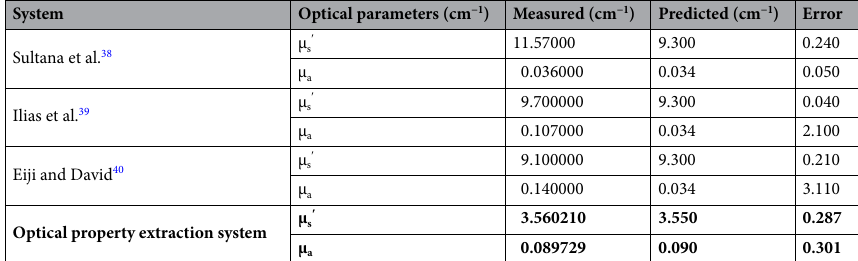
Table 7. Comparison of the proposed system with the existing system. Significant values are in bold.